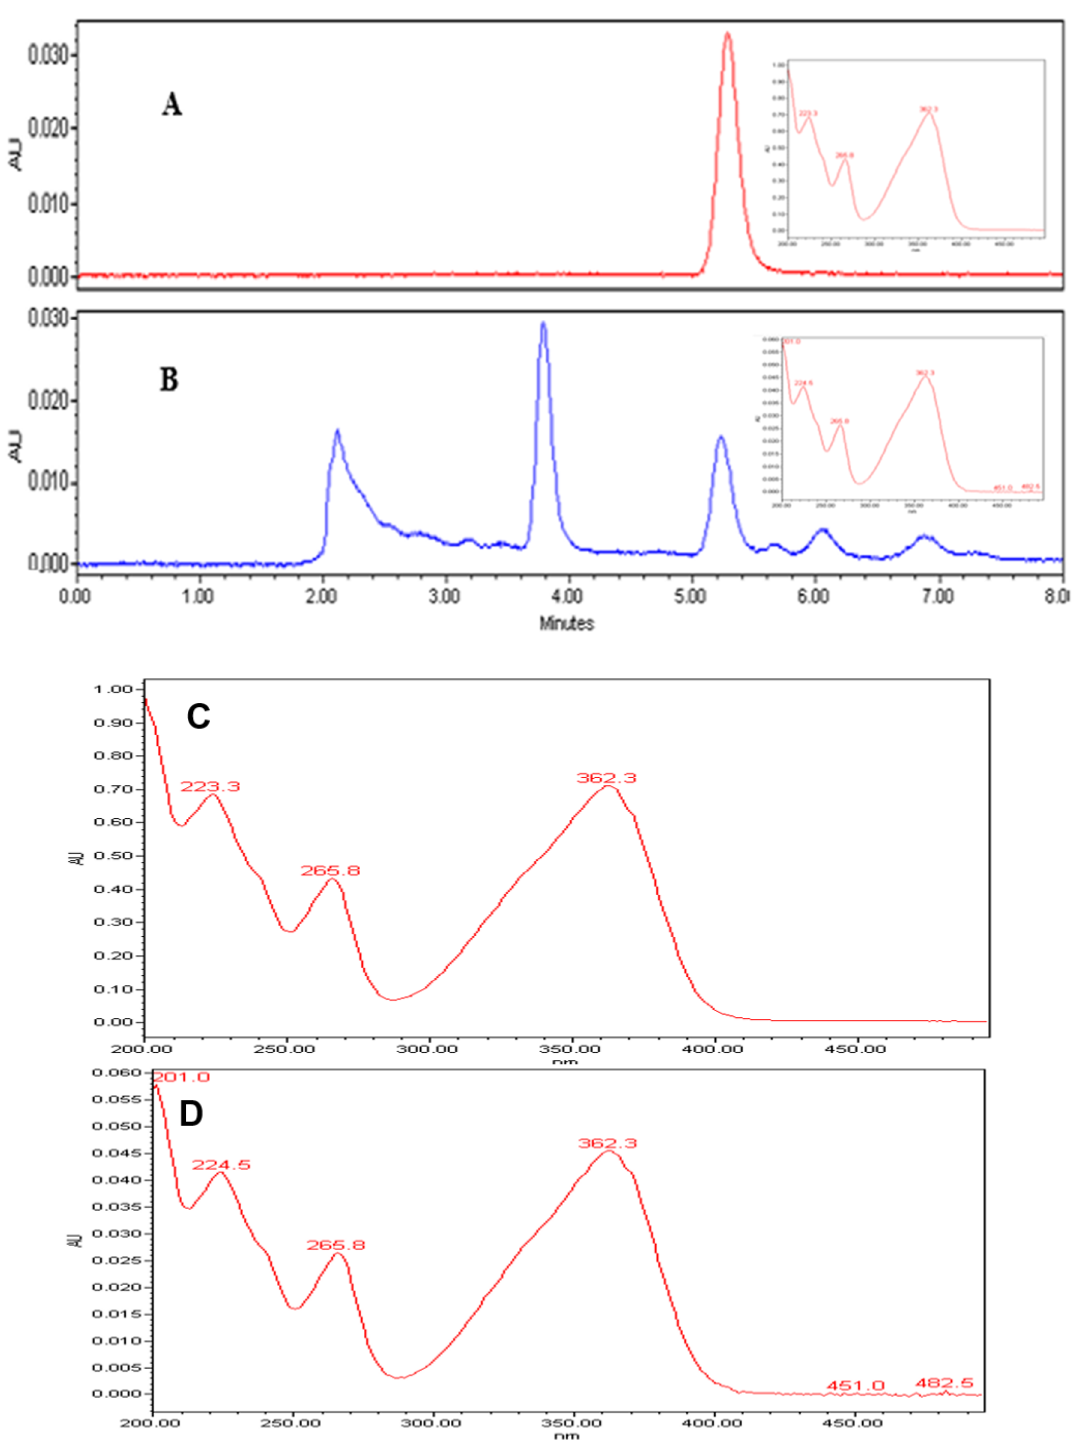
Figure 6. Chromatogram ( A )—the peak of AFB1 standard at 40 ppm; chromatogram ( B )—the peak of AFB1 from the extract at 500 ppm clove oil; the retention times of AFB1 average at 5.23 min in both chromatograms and additional peaks in chromatogram B were not identified in this study. UV spectra ( C , D ) are identical to the peaks eluting at 5.23 min in chromatograms A and B, confirming the presence of AFB1 in the extracts.